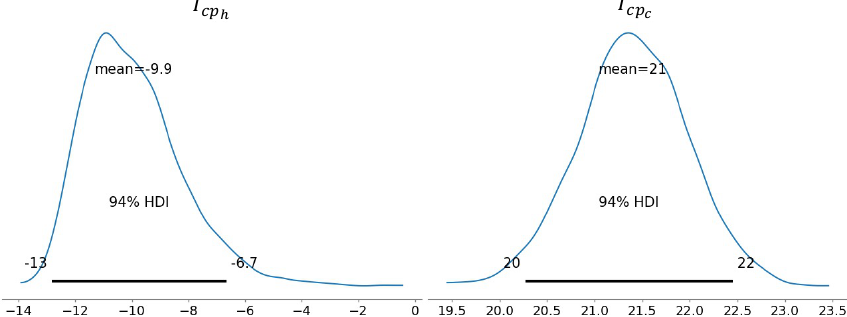
Figure 11. Posterior distributions estimated for the heating and cooling change-point temperatures for the building Rat_health_Gaye .